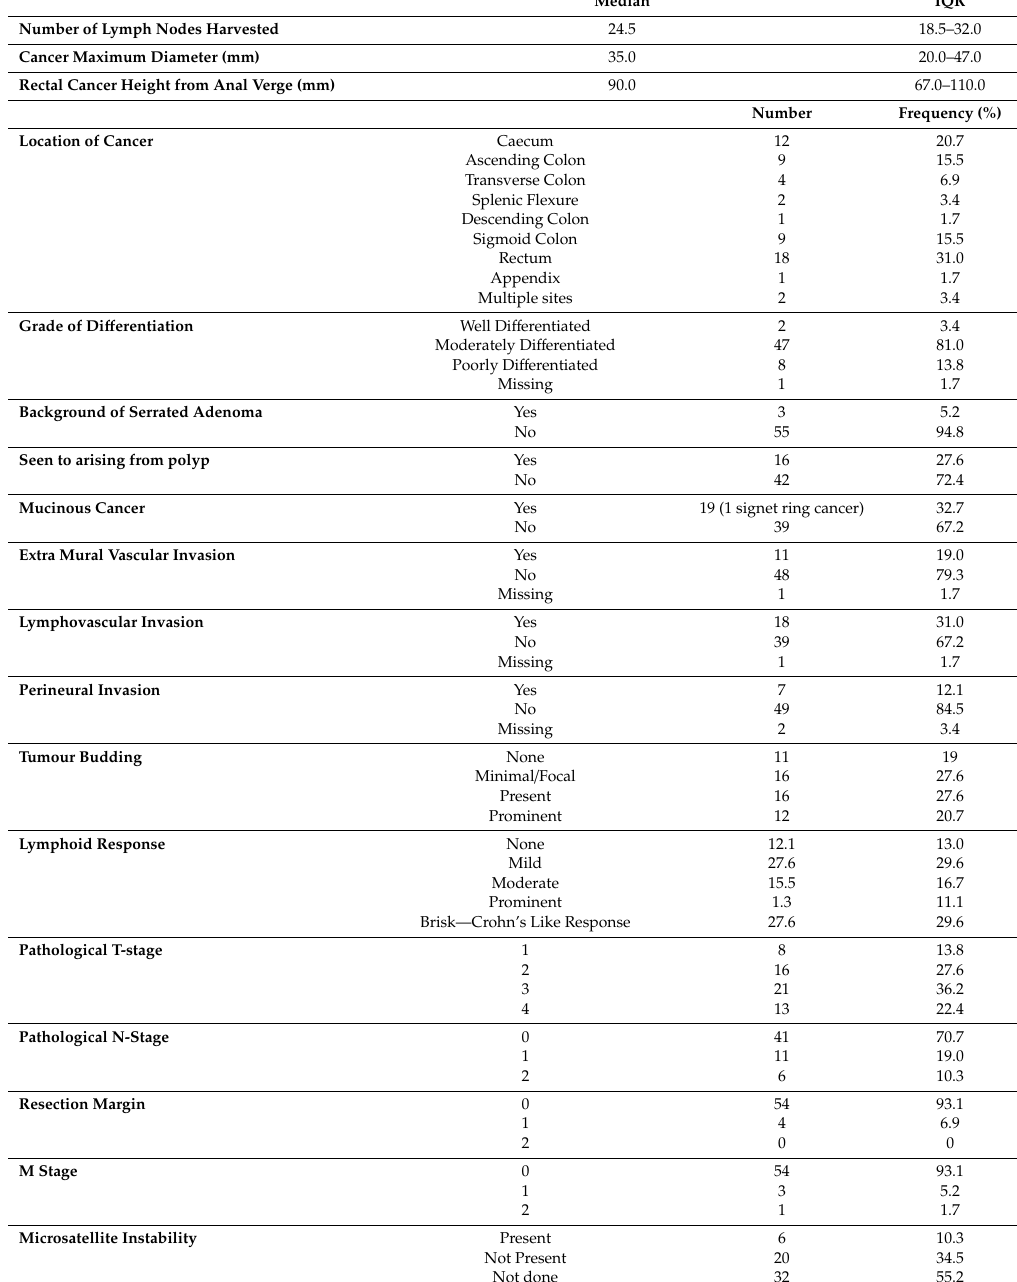
Table 2. Clinical pathological characteristics of colorectal